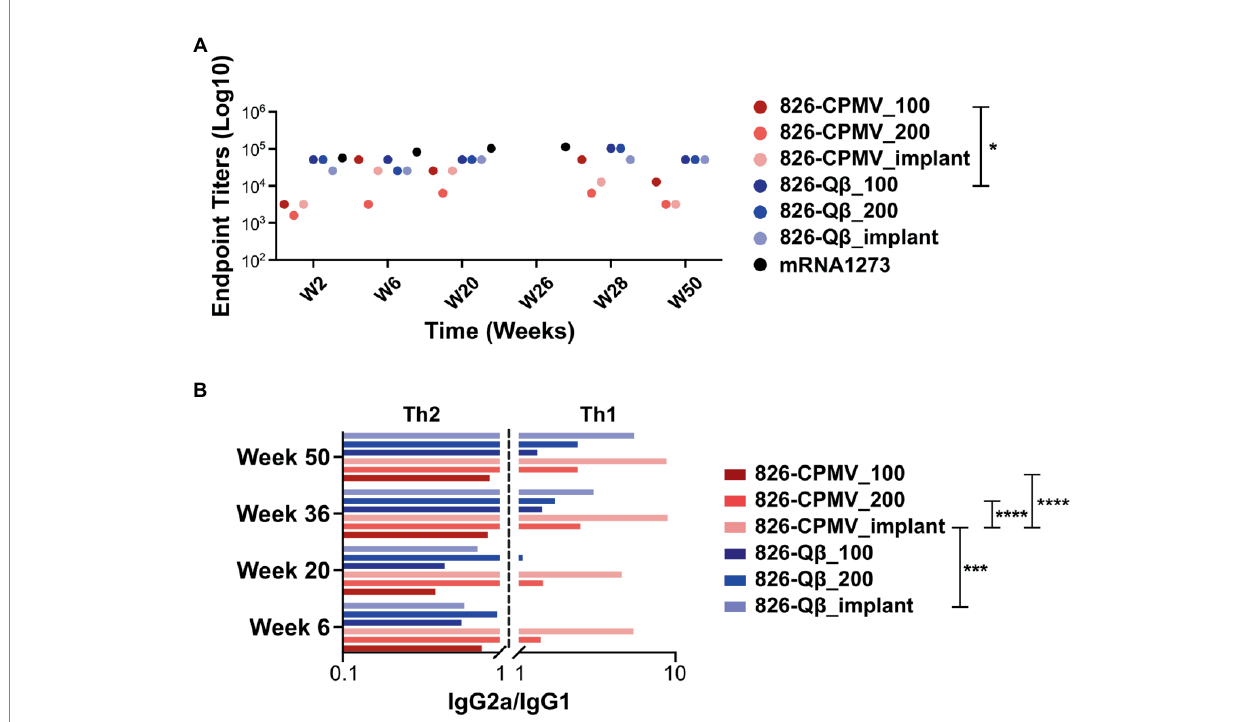
FIGURE 4 (A) End-point IgG titers after the prime–boost administration of CPMV/Q β -based vaccine candidates. All candidates elicited IgG recognizing epitope 826 at 2 weeks post-immunization. Samples from mice were pooled for analysis ( n = 5). (B) IgG subclass profile (IgG2a/IgG1 ratio) from weeks 4–50. A ratio < 1 is considered as a Th2-biased response and a ratio >1 is considered as a Th1-biased response. □ = mRNA-RBD; open-source data of an mRNA- RBD vaccine (Huang et al., 2021). Two-way ANOVA using pairwise multiple comparison followed by Tukey’s multiple comparison test was used to compare between groups. Asterisks in the Support Information Supplementary Tables S2, S3 indicate significant differences between groups (* p < 0.05; ** p < 0.01, **** p <